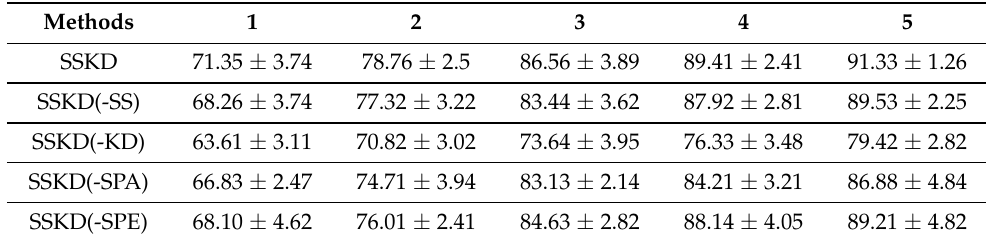
Table 8. The overall classification accuracy for the ablation study conducted on the UP dataset with one to five samples selected from each category.